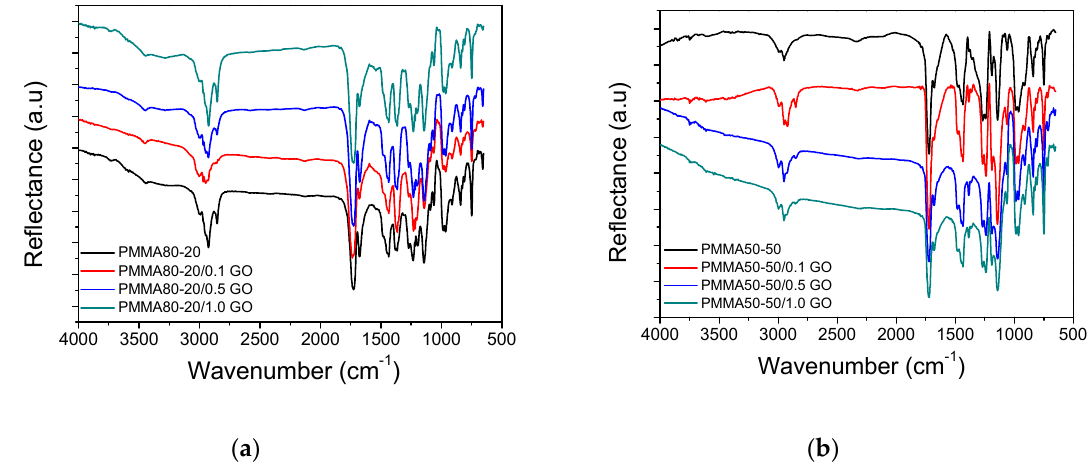
Figure 2. FTIR spectra of neat PMMA and PMMA with 0.1, 0.5, and 1.0% GO obtained under solution polymerization with 80–20 ( a ); 50–50 ( b ) ratio of monomer to solvent.